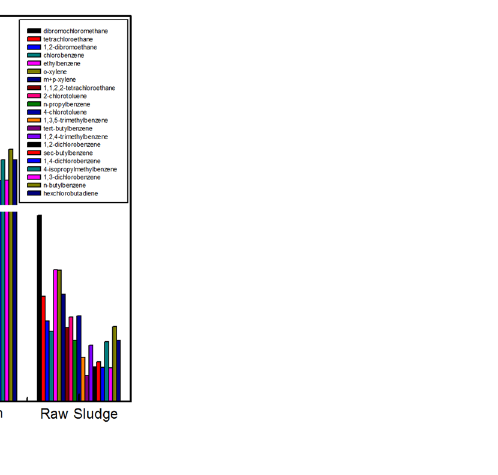
Figure 6. Composition analysis of